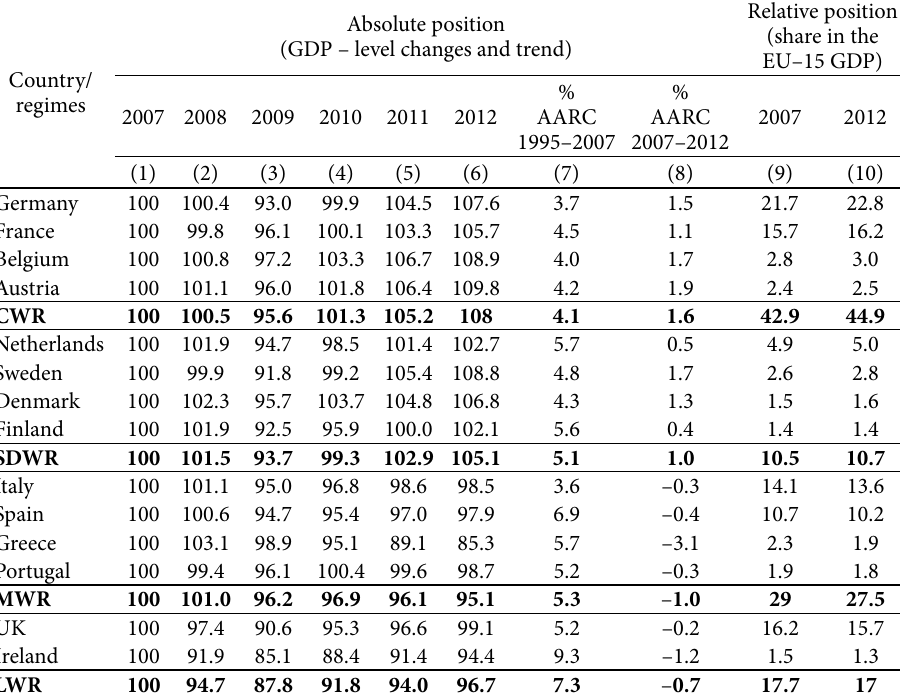
Relative position (share in